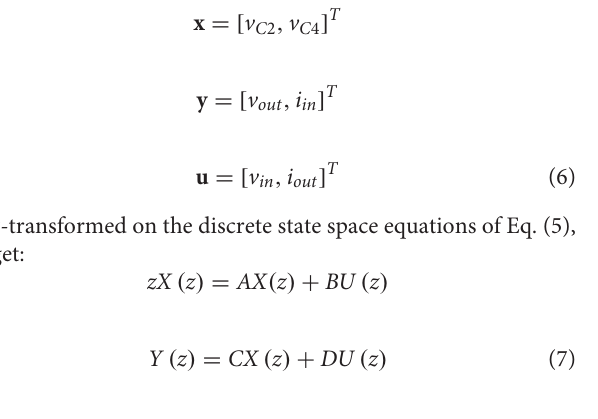
the reverse cut-off voltage is large enough. The three vectors